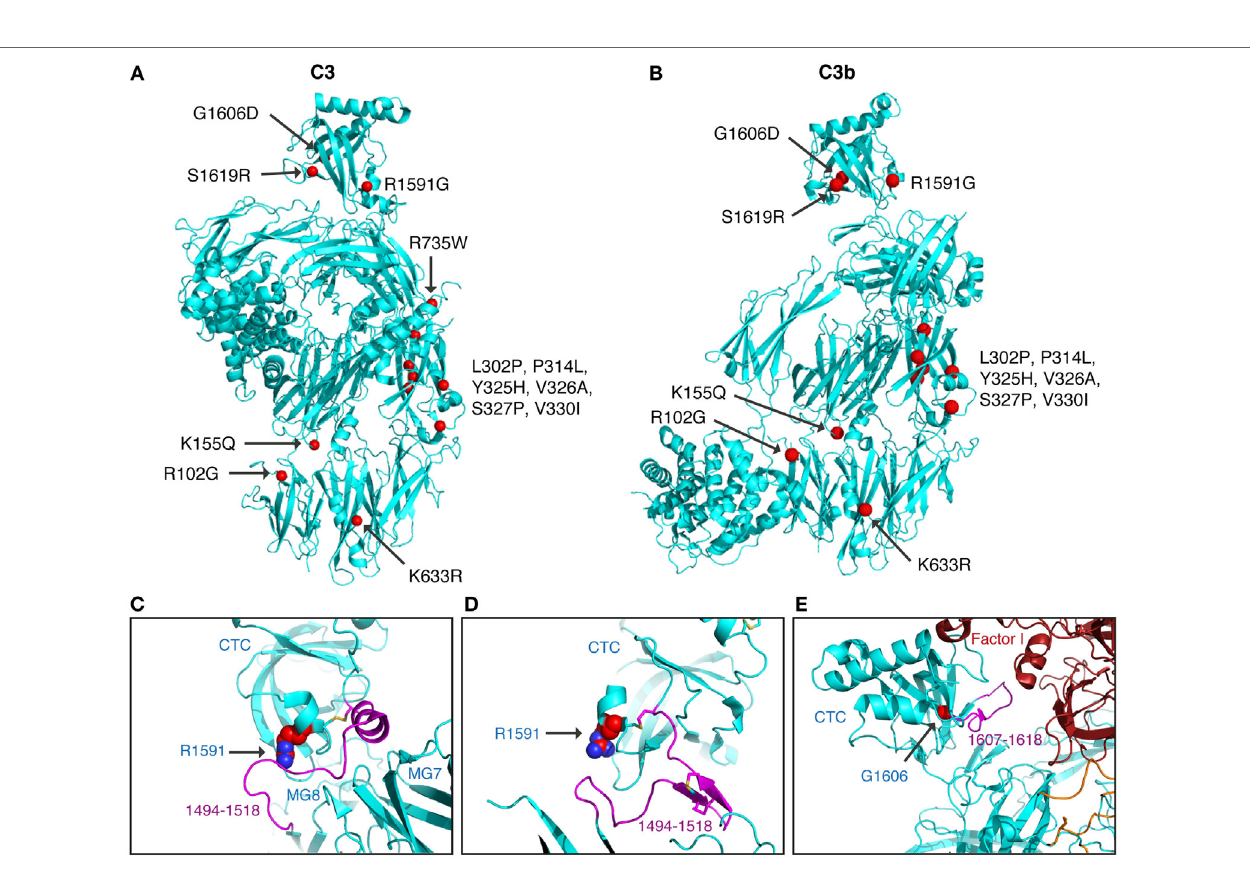
FigUre 6 | Structural analysis of C3 alterations. The C3 alterations analyzed in this study were mapped onto the (a) C3 (pdb-id: 2A73) and (B) C3b (pdb-id: 5FO7) structures, using the molecular graphics program PyMOL. R735W is located in C3a and therefore absent in the C3b molecule. For R1591G; structures are shown of (c) C3 (pdb-id: 2A73) and (D) C3b (pdb-id: 5FO7). Both C3 and C3b are colored in cyan with indicated in purple the neck region (res. 1494–1518), connecting the CTC domains to the C3 and C3b body. R1591 is indicated by spheres and disulfide bridge Cys1518–Cys1590 shown in sticks. (e) For G1606D; the structure of C3b—mini-factor H—factor I (pdb-id: 5O32) is shown. The glycine C[alpha] atom is indicated by a red sphere. Mutation G1606D likely induces local rearrangement affecting its subsequent loop (res. 1617–1618, highlighted in purple) that is directly involved in contacting factor I.